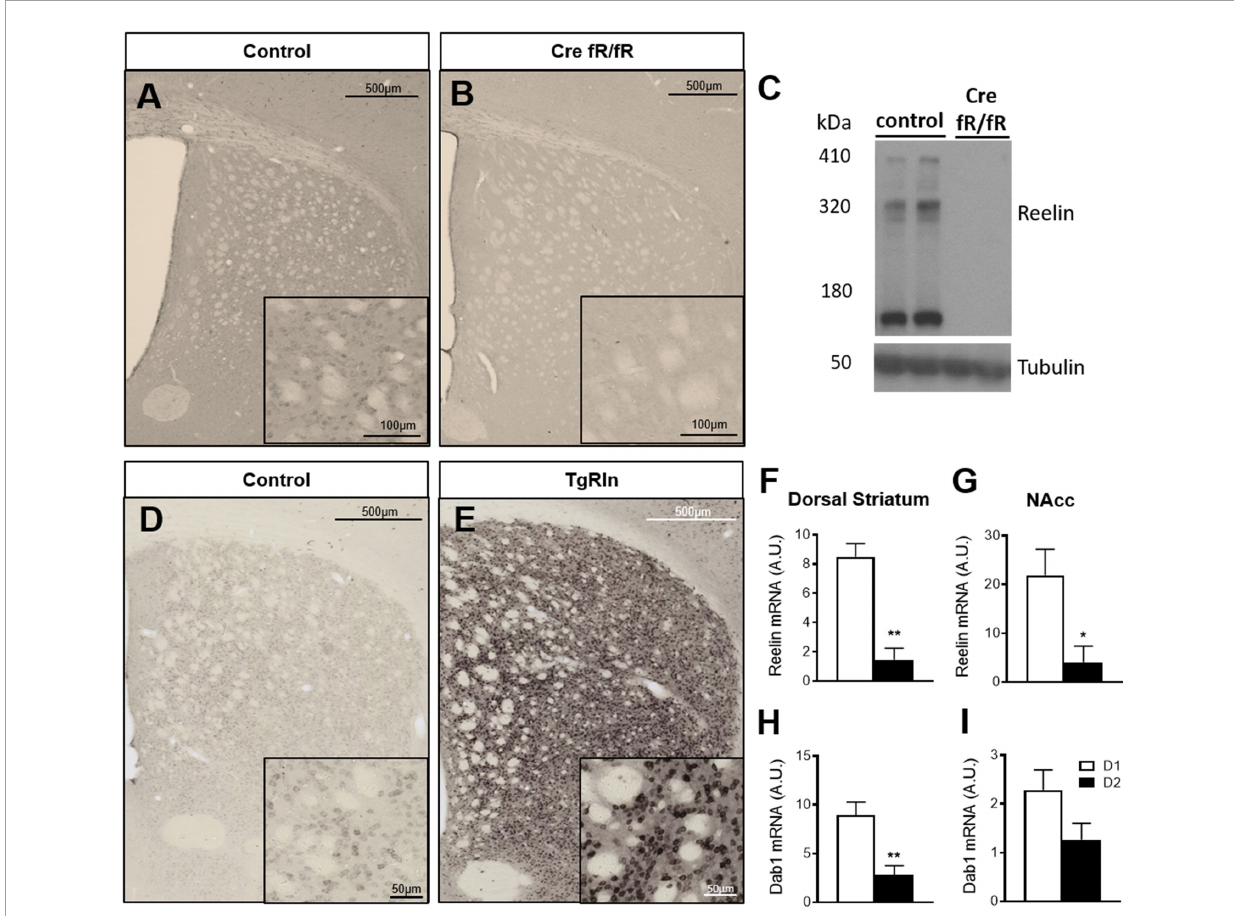
FIGURE1 Reelin in the striatum is mainly expressed by D1 striatonigral MSNs. (A–E) Immunohistochemistry and Western blot for Reelin show that it is absent in Cre fR/fR mice (B,C) compared to the fR/fR littermates (control, A,C ) while it is clearly overexpressed in the striatum of TgRln mice (E) compared to transgenic littermates with an inactive form of the Reelin gene insertion without tTA (controls, D ). (F,G) Quantification of Reelin mRNA levels in the dorsal striatum (F) and NAcc (G) of D1/D2-TRAP mice ( n = 3–4). (H,I) Quantification of Dab1 mRNA levels in the dorsal striatum (H) and NAcc (I) of D1/D2-TRAP mice ( n = 4–7). Scale bar: (A,B,D,E) , 500 µ m; high magnification insets (A,B) , 100 µ m, (D,E) , 50 µ m. NAcc, nucleus accumbens; D1, dopamine 1 receptor; D2, dopamine 2 receptor. Statistical analysis was performed using Student’s t -test; significant differences were established at * p < 0.05, ** p < 0.01. Data represent means ±